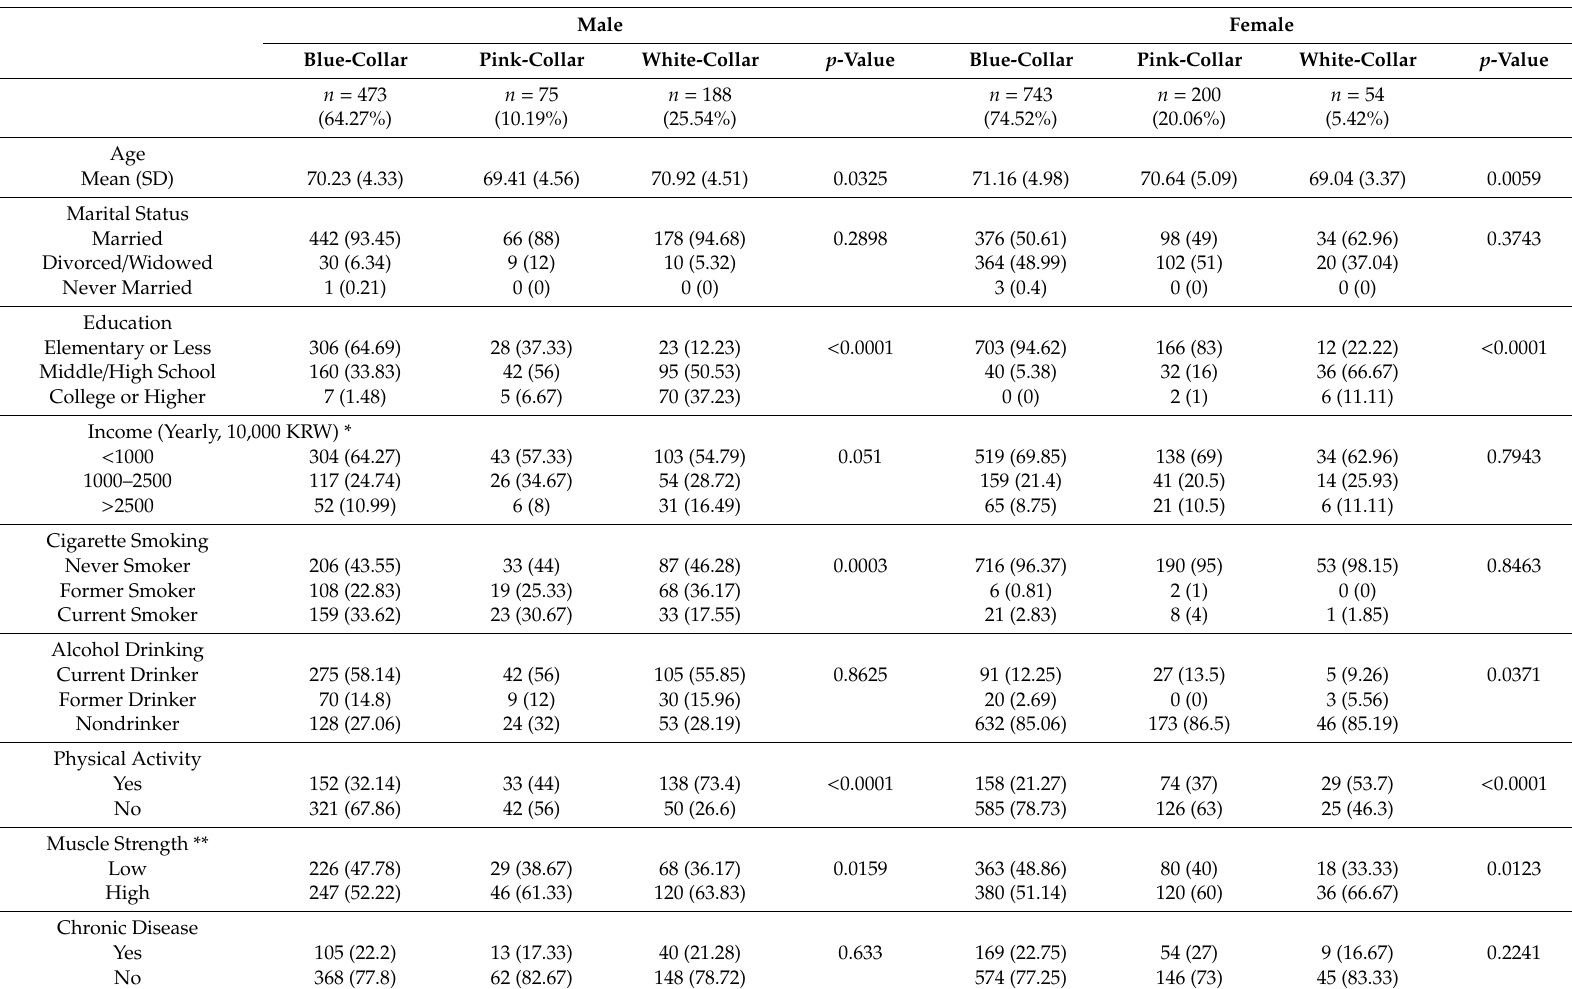
Table 1. Characteristics of the study population according to the longest-held lifetime occupation by